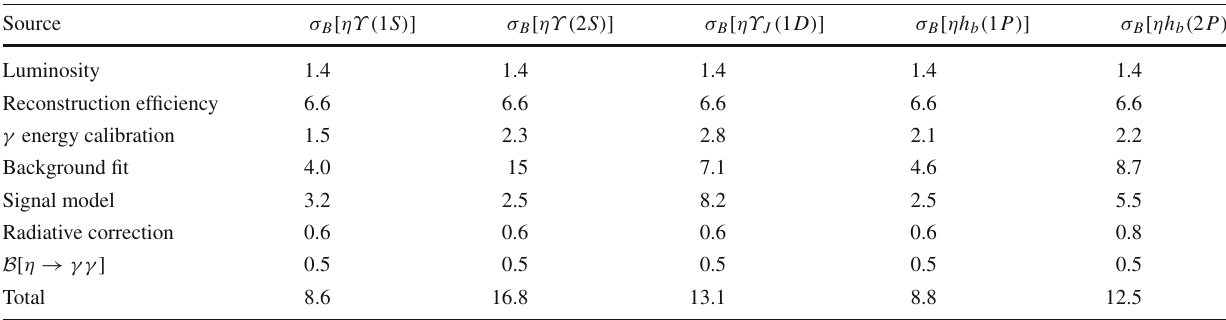
energy calibration affects both the signal resolution and the η